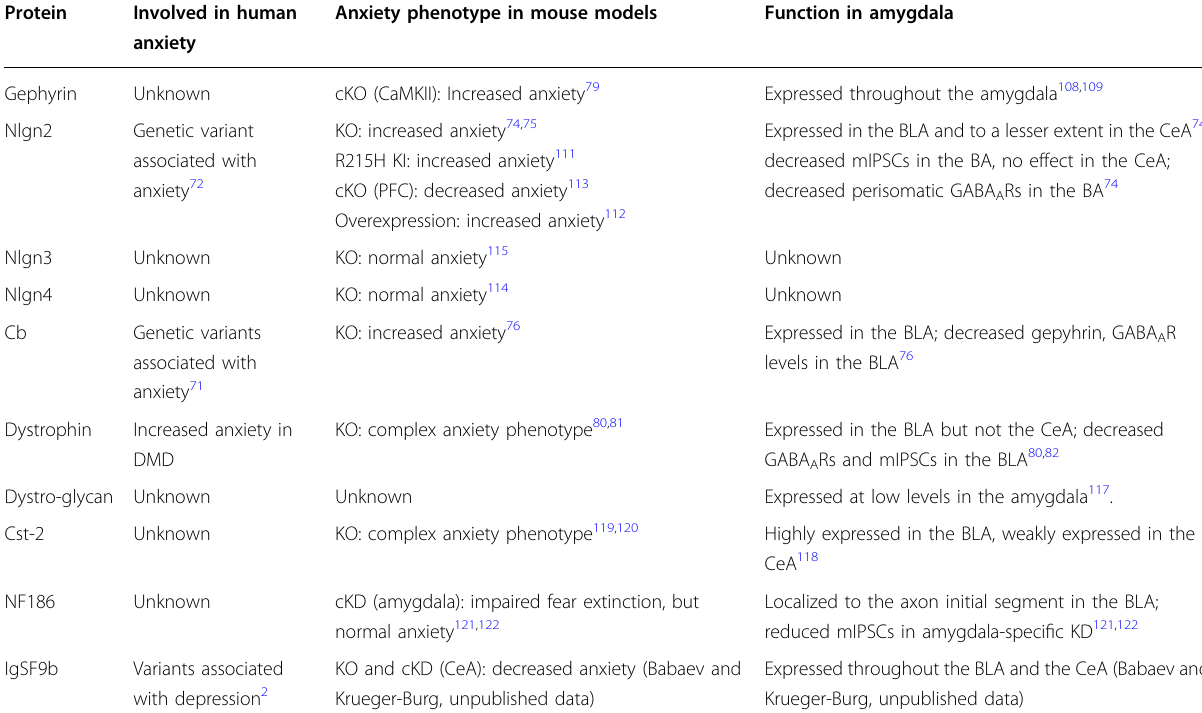
Table 3 Inhibitory synapse organizers that are linked to the amygdala anxiety circuitry Protein Involved in